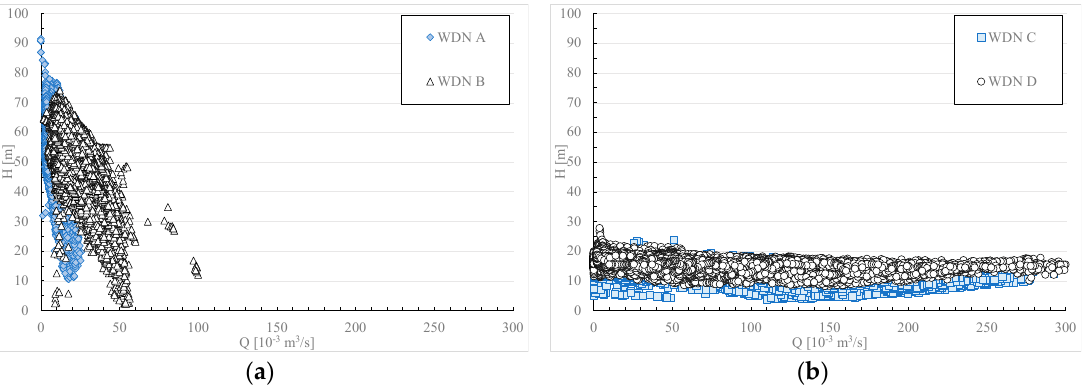
Figure 4. Available head drop vs. volume flow rate (measured values). ( a ) WDN A and B; ( b ) WDN C and D.